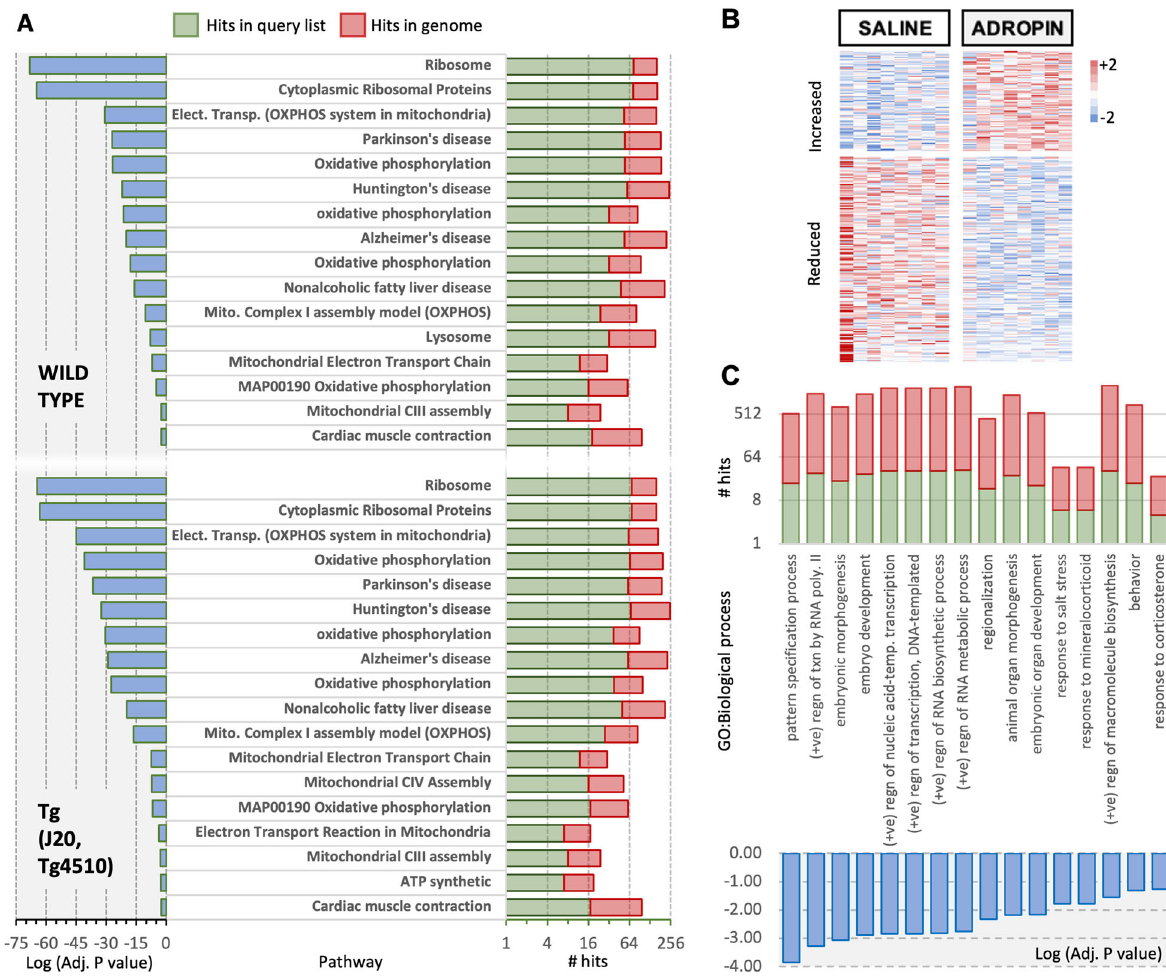
Fig. 7 Adropin effects on the transcriptome of the aged mouse brain. A Gene enrichment analysis of genes correlating with the ENHO transcript in wild type ( n = 63) or transgenic mouse models used in Alzheimer ’ s disease ( n = 58) (GSE125957). Pathways correlated with ENHO expression were similar between genotypes and are related to mitochondrial processes and synthesis of large macromolecules. B Heat map showing genes increased or reduced following adropin treatment of 18-month-old male B6 mice with saline or adropin 34-76 for 1 month ( n = 8/group). These mice were selected from the animals used in the behavioral studies shown in Fig. 8. C Results from gene enrichment analysis showing biological processes responding to adropin 34-76